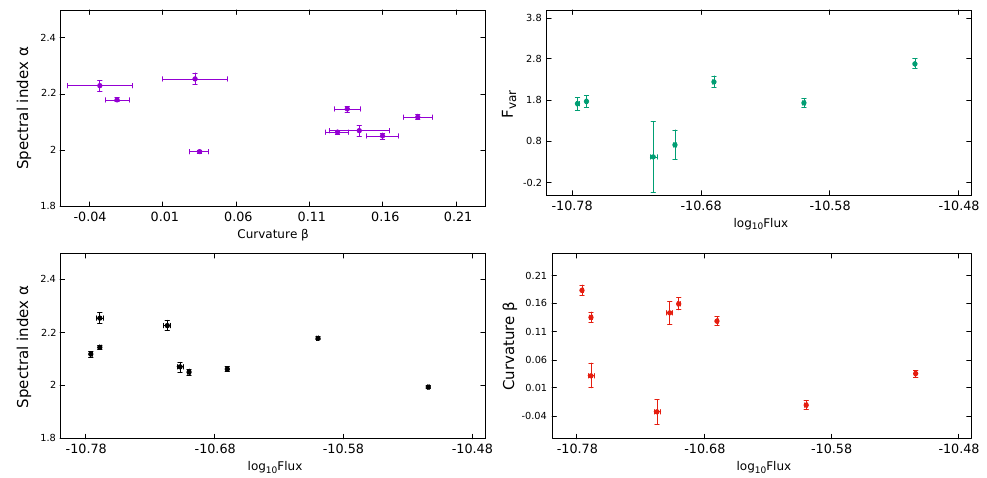
Figure 4. Relation between α versus β ; F var versus Flux; α versus Flux and β versus